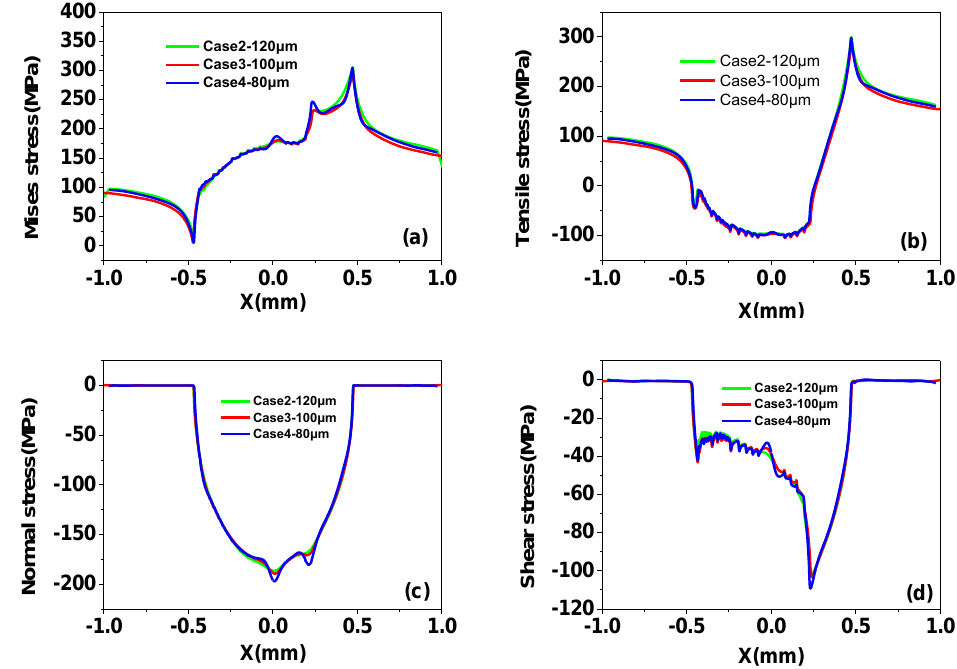
Figure 17. ( a ) Mises stress, ( b ) tensile stress, ( c ) normal stress, ( d ) shear stress distribution on the contact surface for different distance cases.